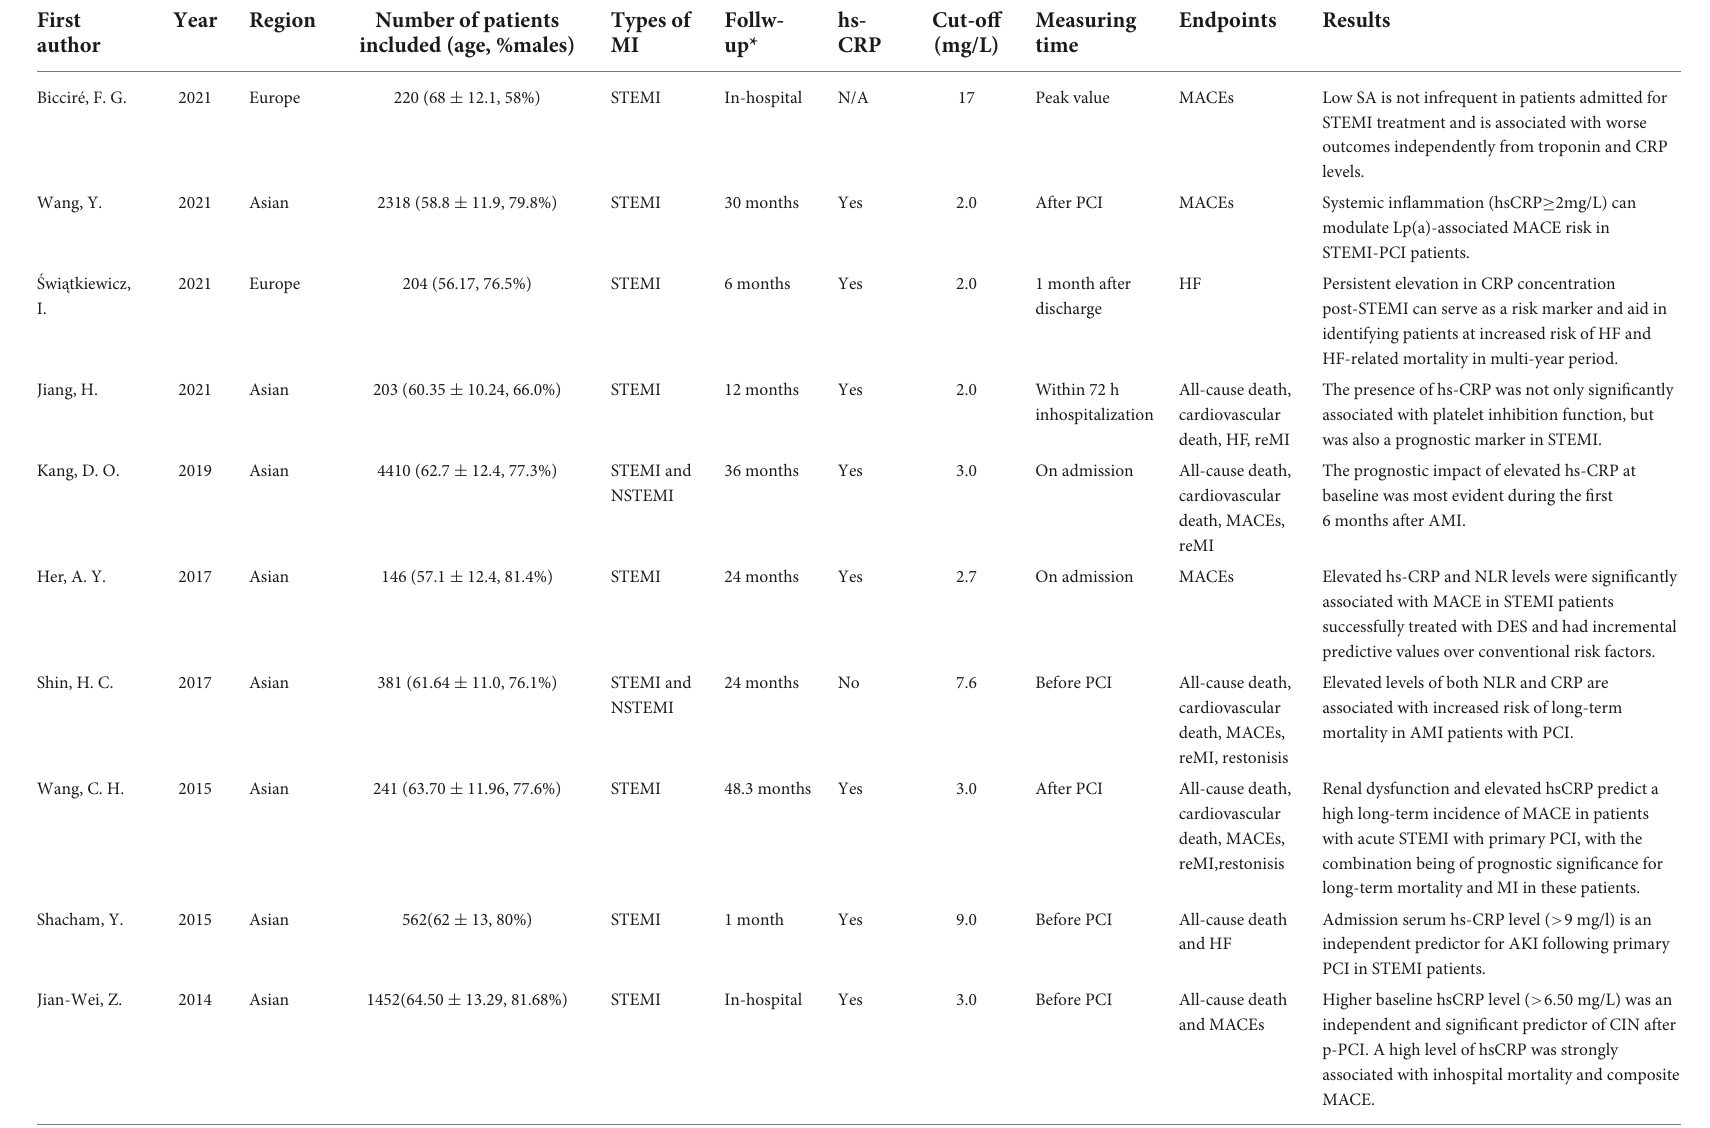
TABLE 1 Characteristics of studies included in the meta-analysis.